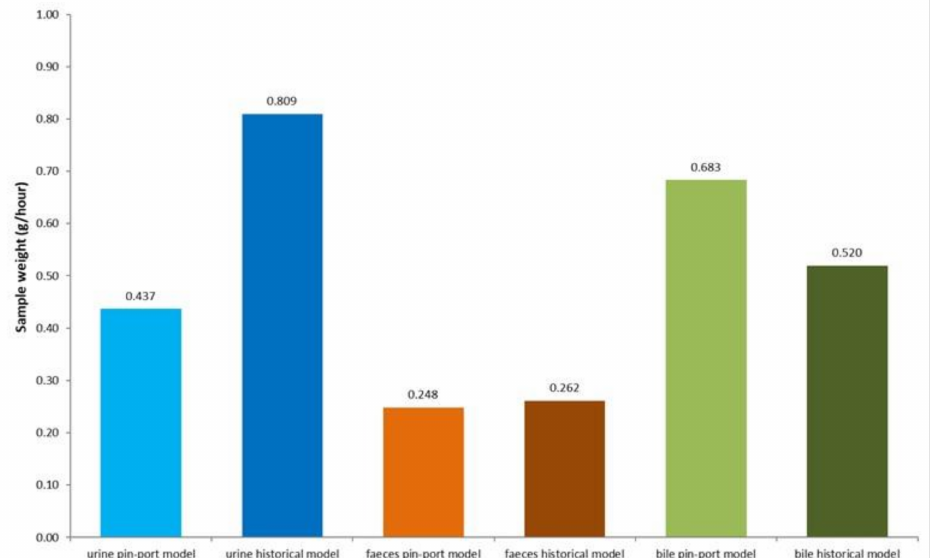
Figure 4. Mean excretory sample weights (g) from five collection periods (see Appendix A for study design) compared to ten studies using the previous BDC (historical) method. Sample weight data from all five sessions were totaled for individual animals and the mean data for the six rats are presented.